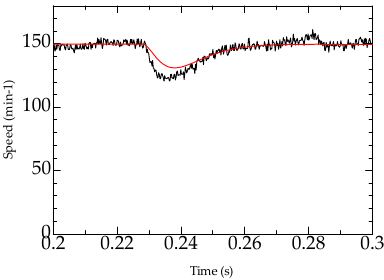
Figure 15. Disturbance response of the initial PI ‐ P gain controller.